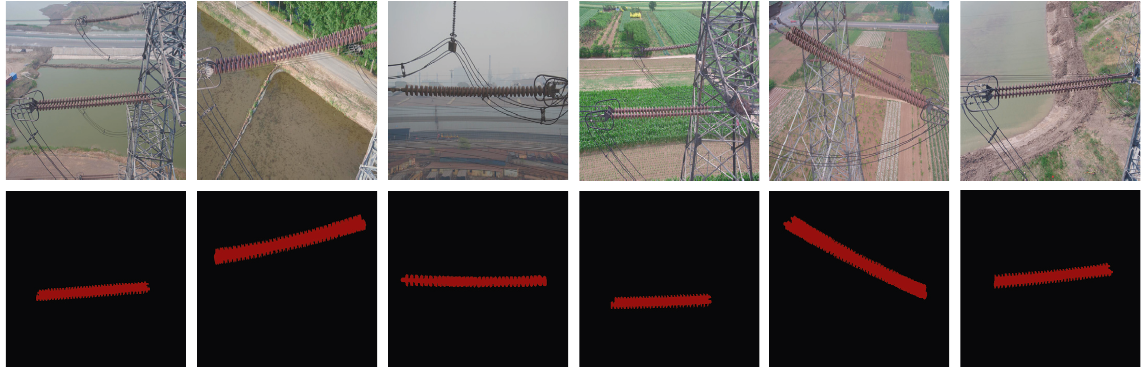
Figure 6: Example of train sample and label data.